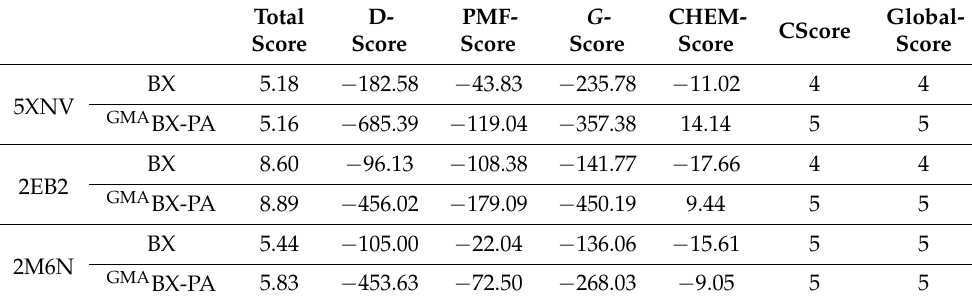
Figure 10. Images of GMA BX-PA docking models. ( a ) An image of the GMA BX-PA docking model of 5XNV. ( b ) An image of the GMA BX-PA docking model of 2EB2. ( c ) An image of the GMA BX-PA docking model of 2M6N. Table 3. Molecular docking score.